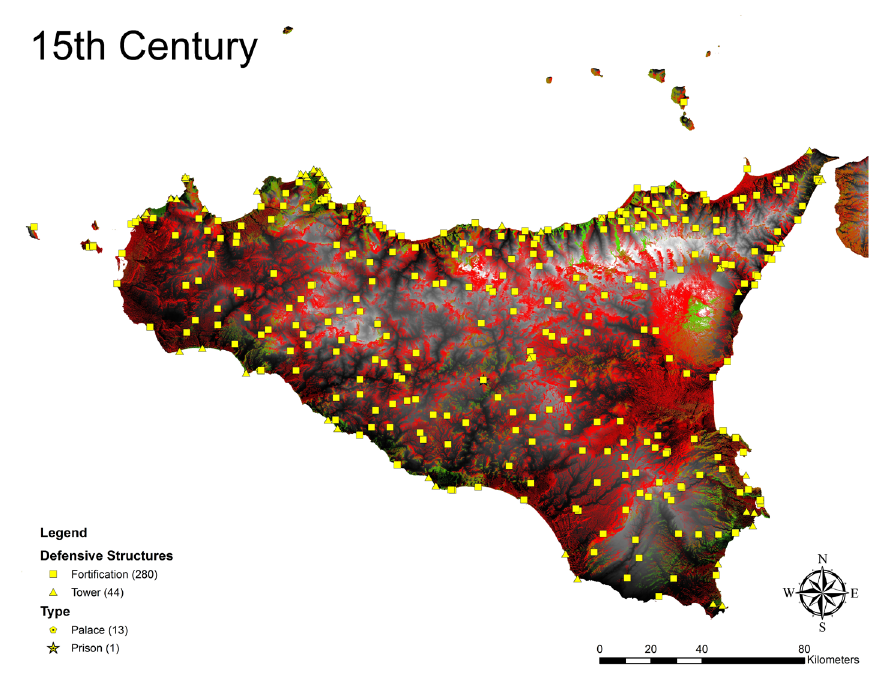
Figure 6. Figure showing the distribution of defensive structures and their viewsheds in the 15th century. Fortifications are represented by squares and the area they have surveillance over is in green. Also included are, palaces represented by hexa- gons, and prisons represented by a star. Image derived from an ASTER GDEM (a product of NASA and METI).